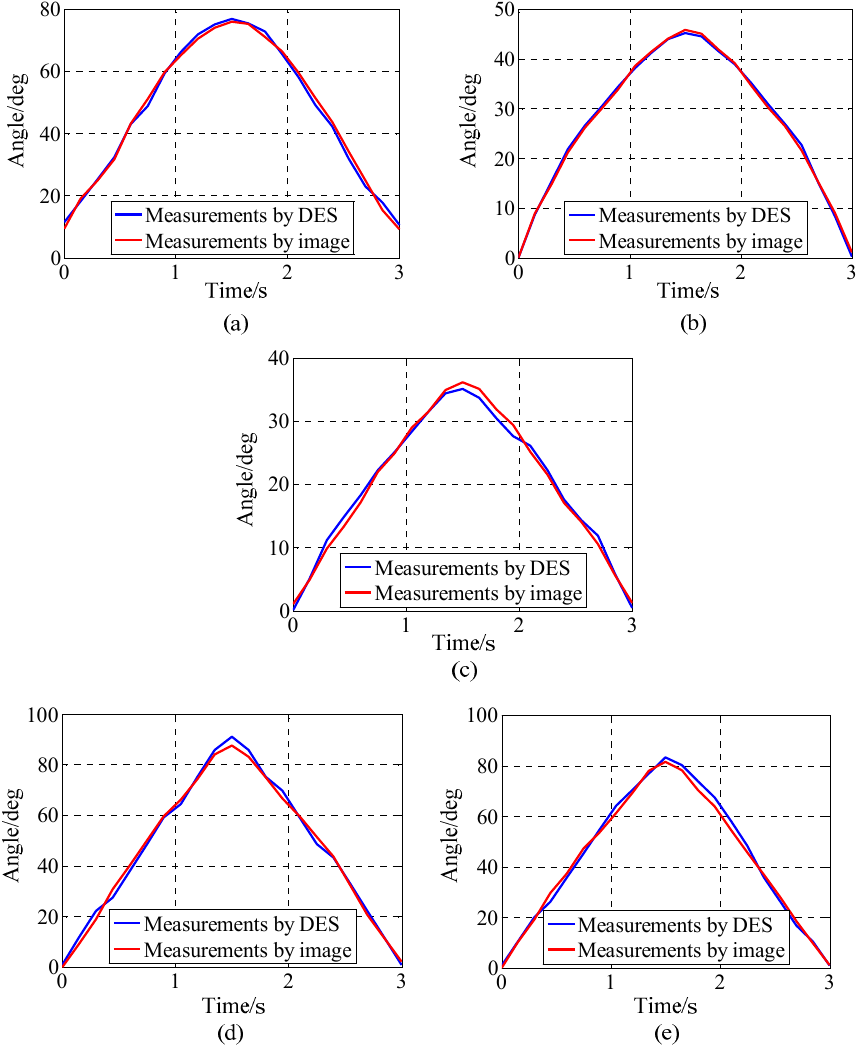
Figure 6. Comparison of measurements by DES and measurements by image processing: ( a ) Flexion; ( b ) Extension; ( c ) Ulnar deviation; ( d ) Pronation; ( e ) Supination.